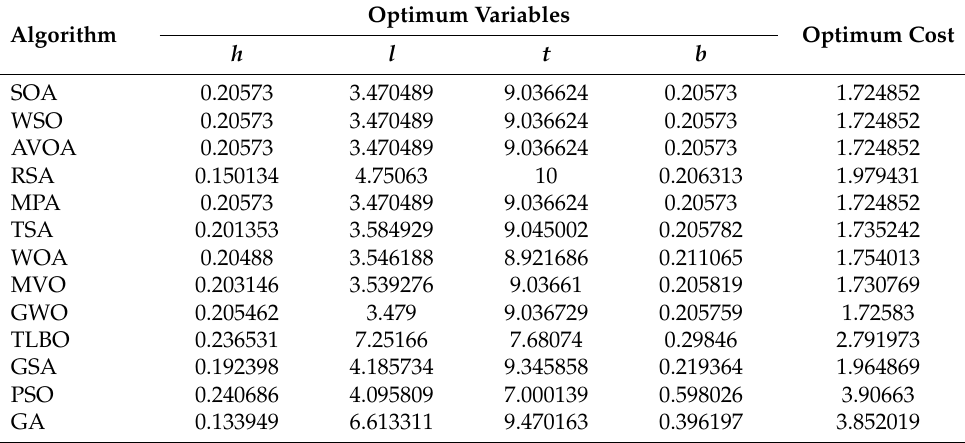
Table 13. Performance of optimization algorithms on the welded beam design problem.